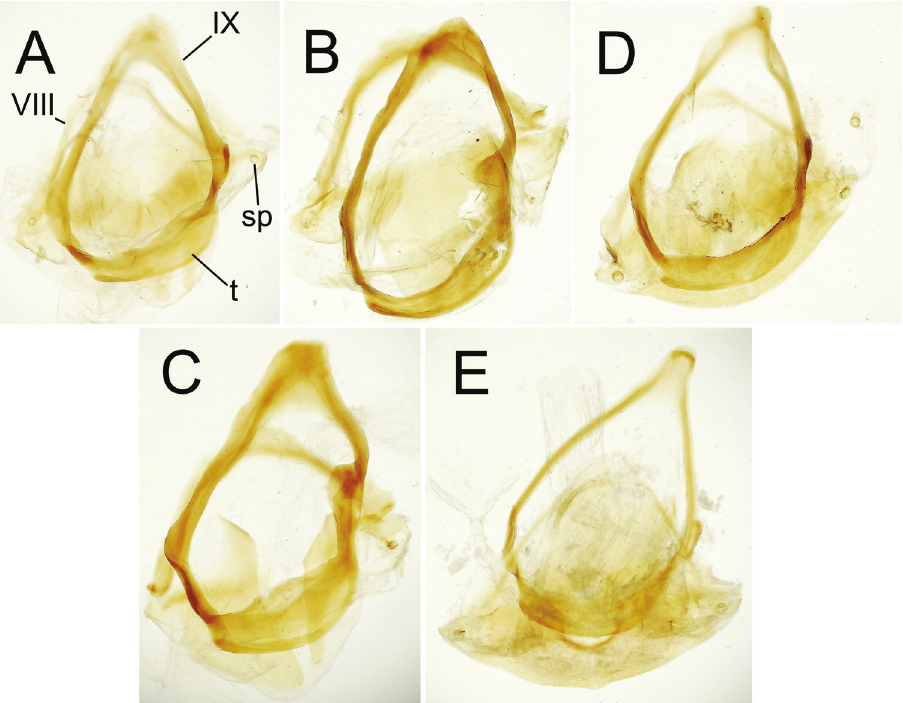
Figure 6. Structures associated with abdominal segments VIII and IX for Theprisa spp., dorsal view A T. otway B T. convexa C T. montana D T. australis E T. darlingtoni. Abbreviations: VIII, antecostal apodeme of abdominal segment VIII; IX, antecostal apodeme of abdominal segment IX; sp, spiracle of segment VIII; t, tergite of segment IX. Scale bars: 0.5